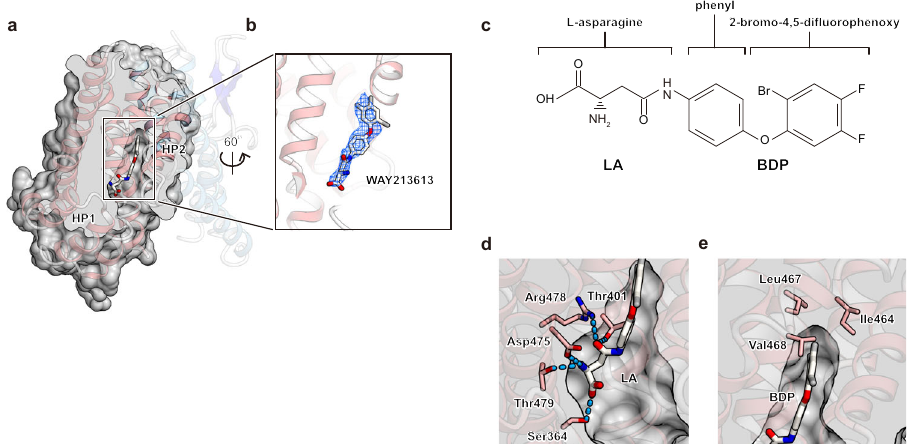
Fig.4|IFS-WAY213613state.a , b StructureoftheIFS-WAY213613state. a Cut-away representation of the cavity with WAY213613. b Close-up views of the WAY213613- bound site. The F o – F c omit map of WAY213613 is contoured at 3.0 σ (normalized withinmask),andshownasabluemesh. c ThestructureofWAY213613.WAY213613